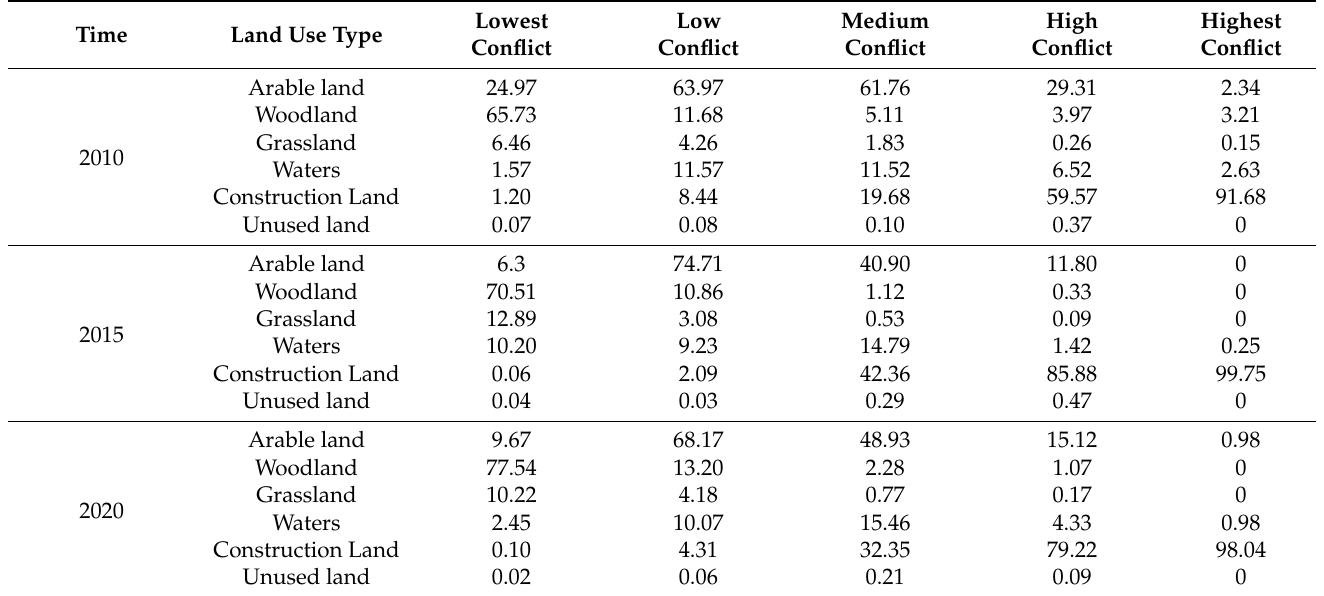
Figure 8. Composition of land use in different years of each conflict types (A, B, and C refer to 2010, 2015, and 2020; 01, 02, 03, 04, 05 refer to lowest, low, medium, high, highest spatial conflict levels). Table 4. The proportion of different land use types in each conflict level.